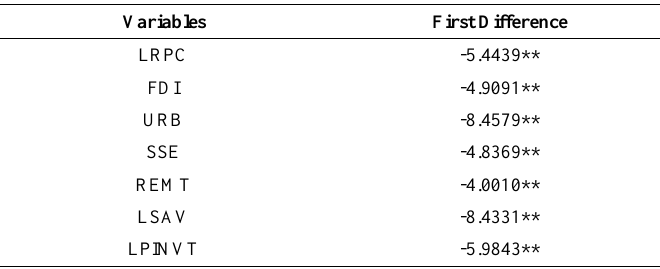
Table 1.Test for Unit- Root: (ADF with Drift and Trend)